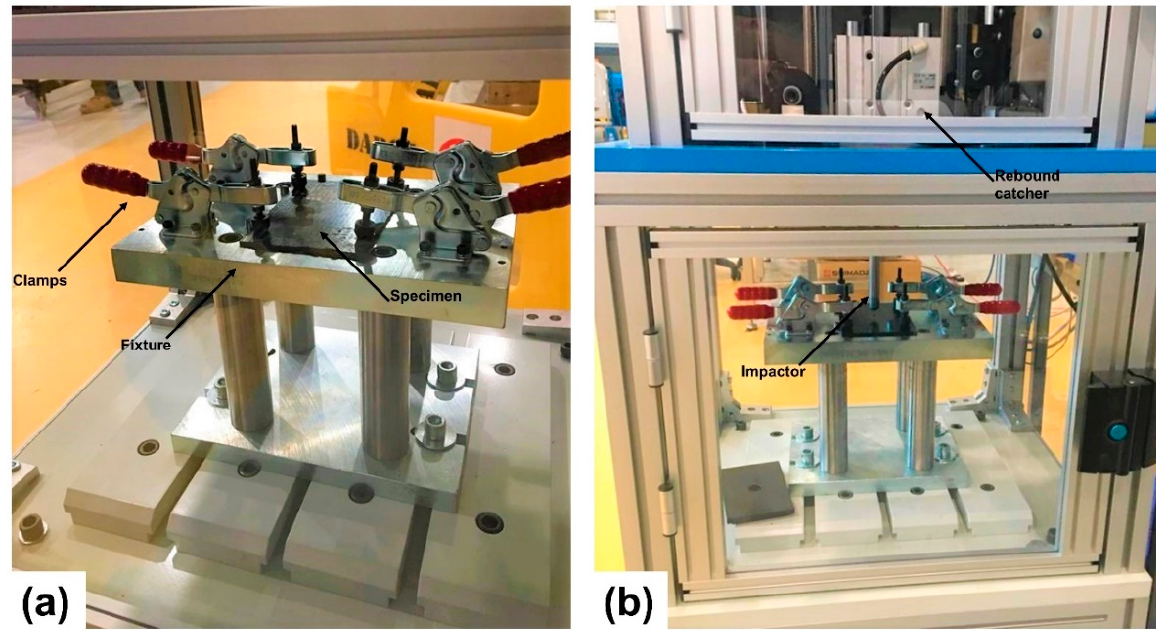
Figure 2. Testing setup ( a ) before and ( b ) after impact.